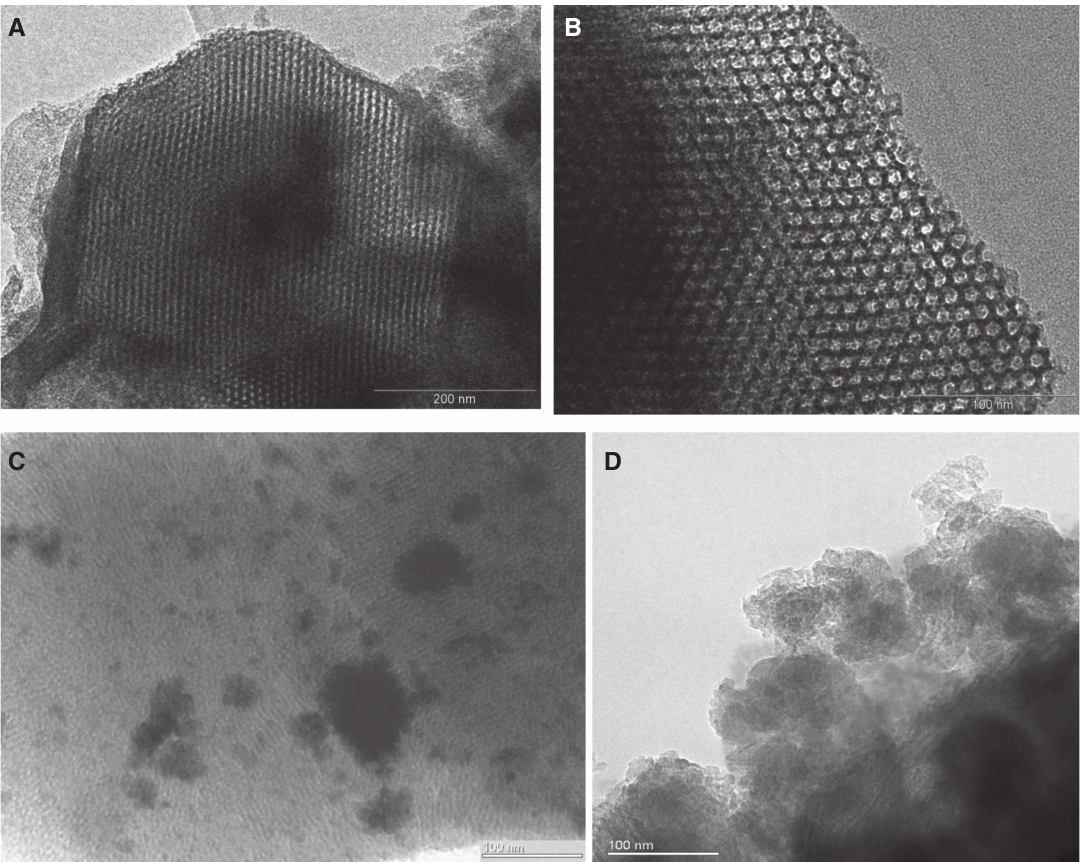
Figure 2 Transmission electron microscopy (TEM) micrographs of: (A, B) 0.5% Co/Al-SBA-15 (top images); and (C, D) 20% Co/Al-SBA-15 (bottom images) at different